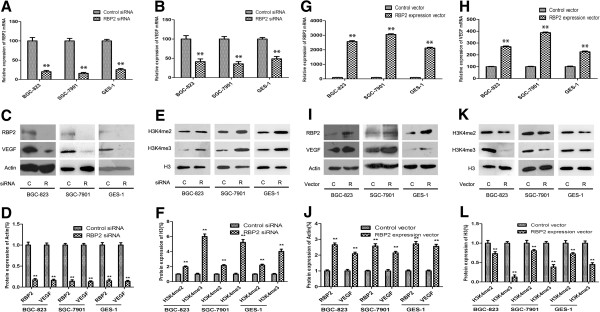
The direct regulation of VEGF by RBP2 in human gastric cancer cells. QRT-PCR analyses of (A) RBP2 and (B) VEGF mRNA level in control and RBP2 siRNA (10 nM)-transfected BGC-823, SGC-7901 and GES-1 cell lines after 72 h. **P < 0.01. Western blot analyses of (C, D) RBP2 and VEGF protein levels and (E, F) tri- and di- methylation of H3K4 in cancer cells treated with control and RBP2 siRNAs. C and R: Control and RBP2 siRNA, respectively. **P < 0.01. QRT-PCR analyses of (G) RBP2 and (H) VEGF mRNA levels in cancer cells transfected with control and RBP2 expression vector (4 μg) after 48 h. **P < 0.01. (I, J) Western blot analyses of RBP2 and VEGF protein levels and (K, L) tri- and di- methylation of H3K4 in cancer cells treated with control and RBP2 expression vectors. Vector C and R: Control pcDNA3.1 and pcDNA3.1-RBP2 expression plasmids, respectively. **P < 0.01. Data are mean ± SEM of 3 independent experiments.